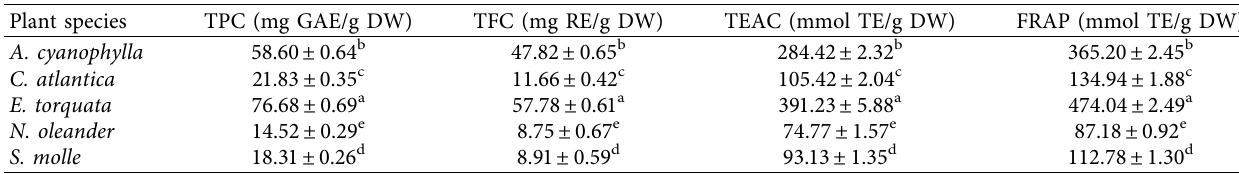
Table 1: Total antioxidant compounds and antioxidant activity of different plant extracts. Plant species